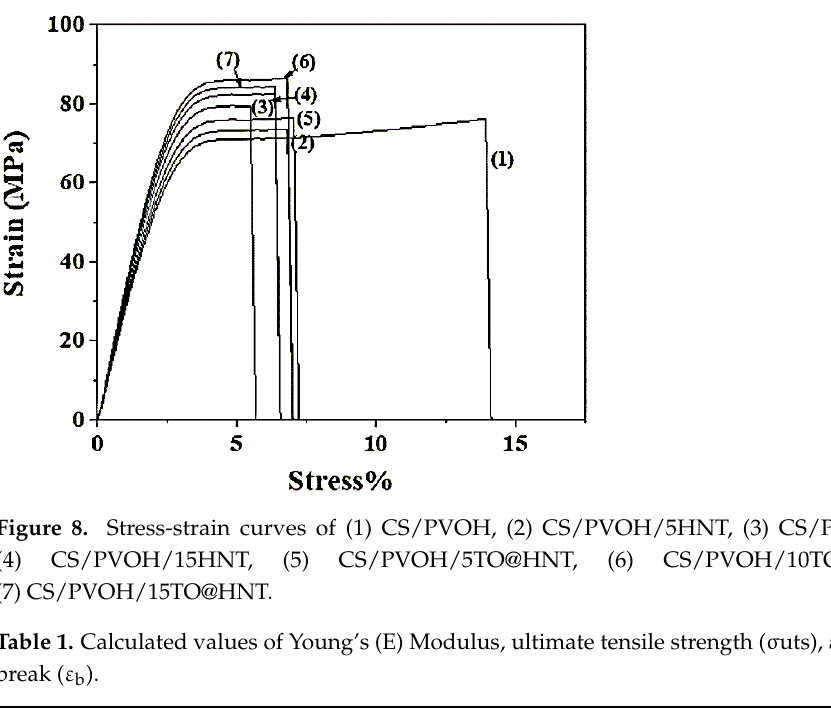
Table 1. Calculated values of Young’s (E) Modulus, ultimate tensile strength (σuts) , and % strain at bre ak (ε b ).